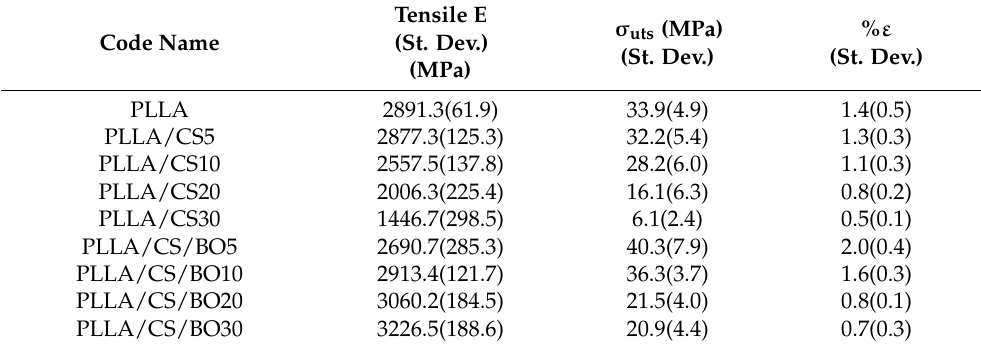
Table 2. Modulus of elasticity (E), tensile strength ( σ uts ), and % elongation at break ( ε b ) of all the tested PLLA/CS and PLLA/CS/Basil essential Oil (BO) films as well as the “blank” PLLA